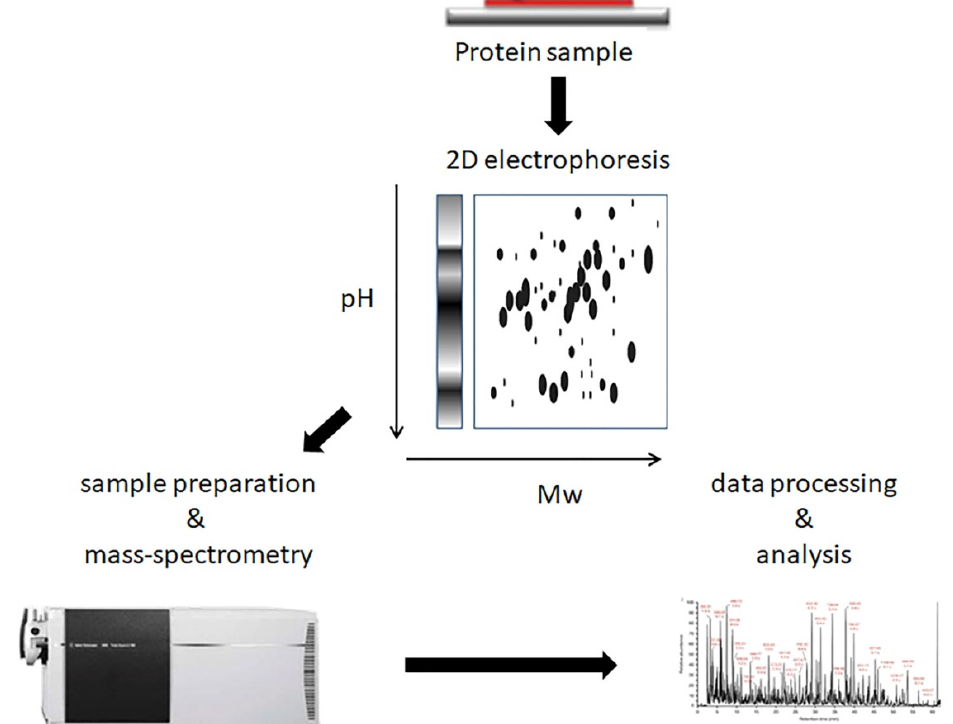
Figure 1. 2D-gel electrophoresis followed by mass spectrometry. The experiment starts from elec- trophoretic separation of protein samples in two directions, by isoelectric point and by molecular weight (M w ). Digestion in- or out-of-gel, mass spectrometry, and data analysis follow electrophore-